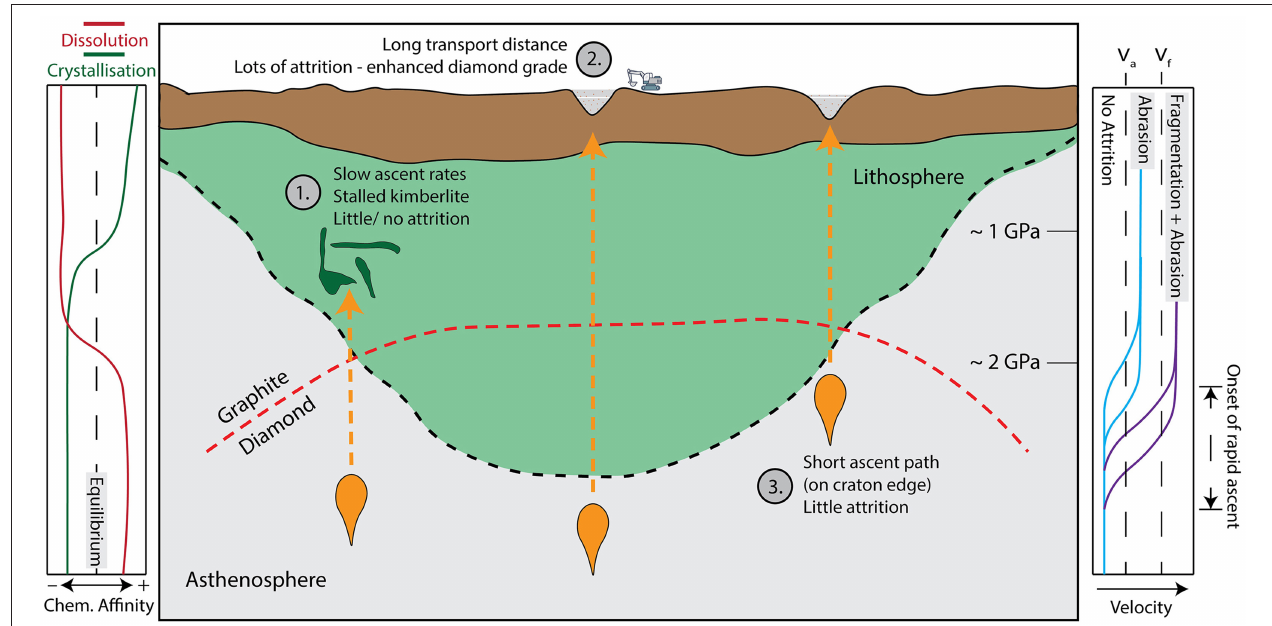
FIGURE 10 | Schematic representation of three different kimberlite ascent paths: (1) Slow ascent leads to the stalling and eventual cooling of the kimberlite. Attrition plays little role in these magmas due to low energy and short residence times. The resulting deposits will show little modification of mantle cargo. (2) Deep-seated melt accumulation followed by early and sustained rapid ascent supports pervasive attrition due to a high energy environment and a long residence time. Resulting deposits will contain heavily rounded olivine grains and potentially an enhanced diamond grade. (3) Shallow-seated melt accumulation and relatively late onset of rapid ascent—attrition occurs only over a short distance. Resulting deposits have olivine (and other indicator minerals) that are less rounded than those observed in deposit